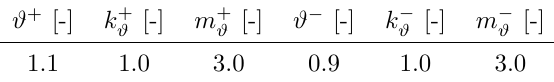
Table 2. Growth parameters used for the simulation of an idealized arterial